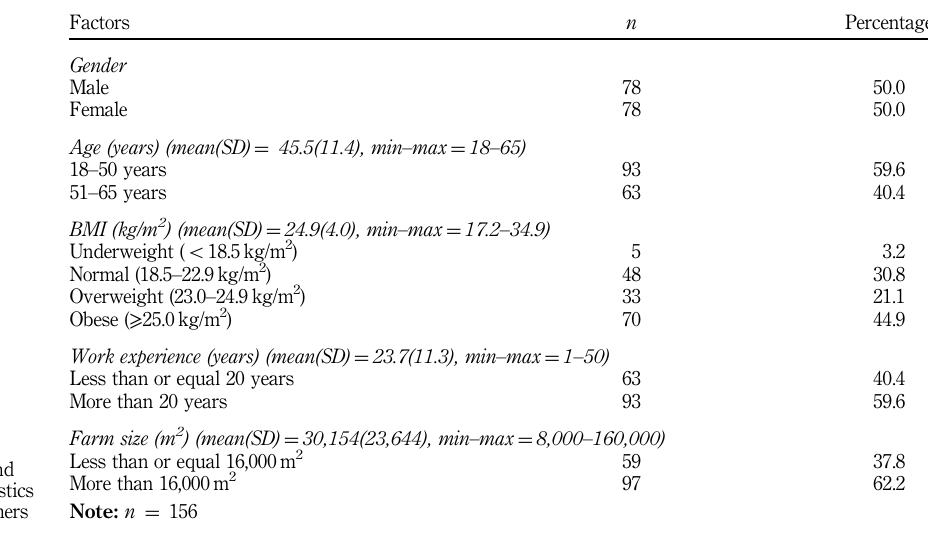
work characteristics among rice